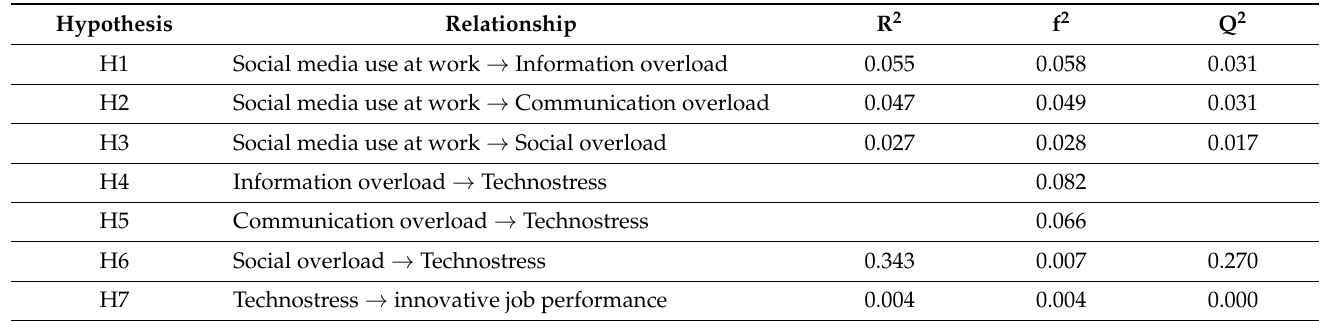
Table 7. The result of the coefficient determination (R Square), effect size (f Square), and predictive relevance (Q Square).